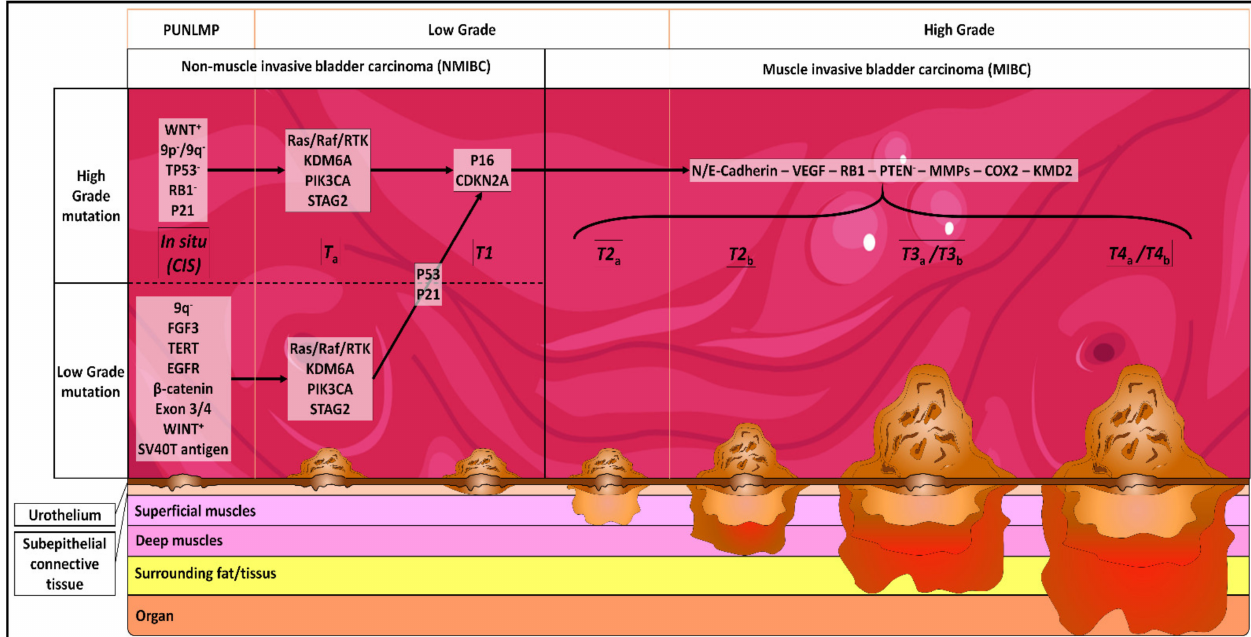
Figure 1. Genetical and physiological evolution of bladder cancer (BC). CIS: carcinoma in situ: “flat tumor”; T a : noninvasive papillary carcinoma; T1: tumor invades subepithelial connective tissue; T2 a : tumor invades superficial muscularis propria (inner half); T2 b : tumor invades deep muscularis propria (outer half); T3 a : tumor invades surrounding fat/tissues micro- scopically; T3 b : tumor invades surrounding fat/tissues macroscopically; T4 a : tumor invades prostatic stroma, uterus, vagina; T4 b : tumor invades pelvic wall, abdominal wall. PUNLMP = papillary urothelial neoplasm of low malignant